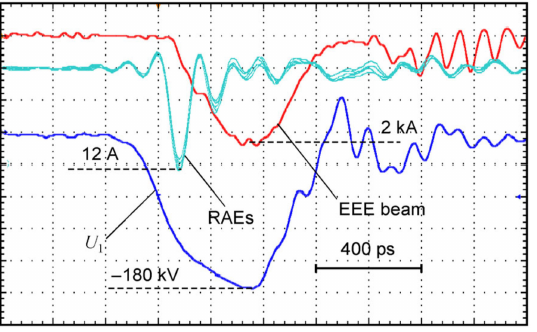
Figure 8. Positions of the vacuum EEE beam current (2 kA) and the RAE flow at p = 760 Torr with an absolute time reference. Binding to the voltage pulse is conditional. Parameters: D = 10 mm; graphite cathode; collector has diameter of 25 mm; B = 2.1